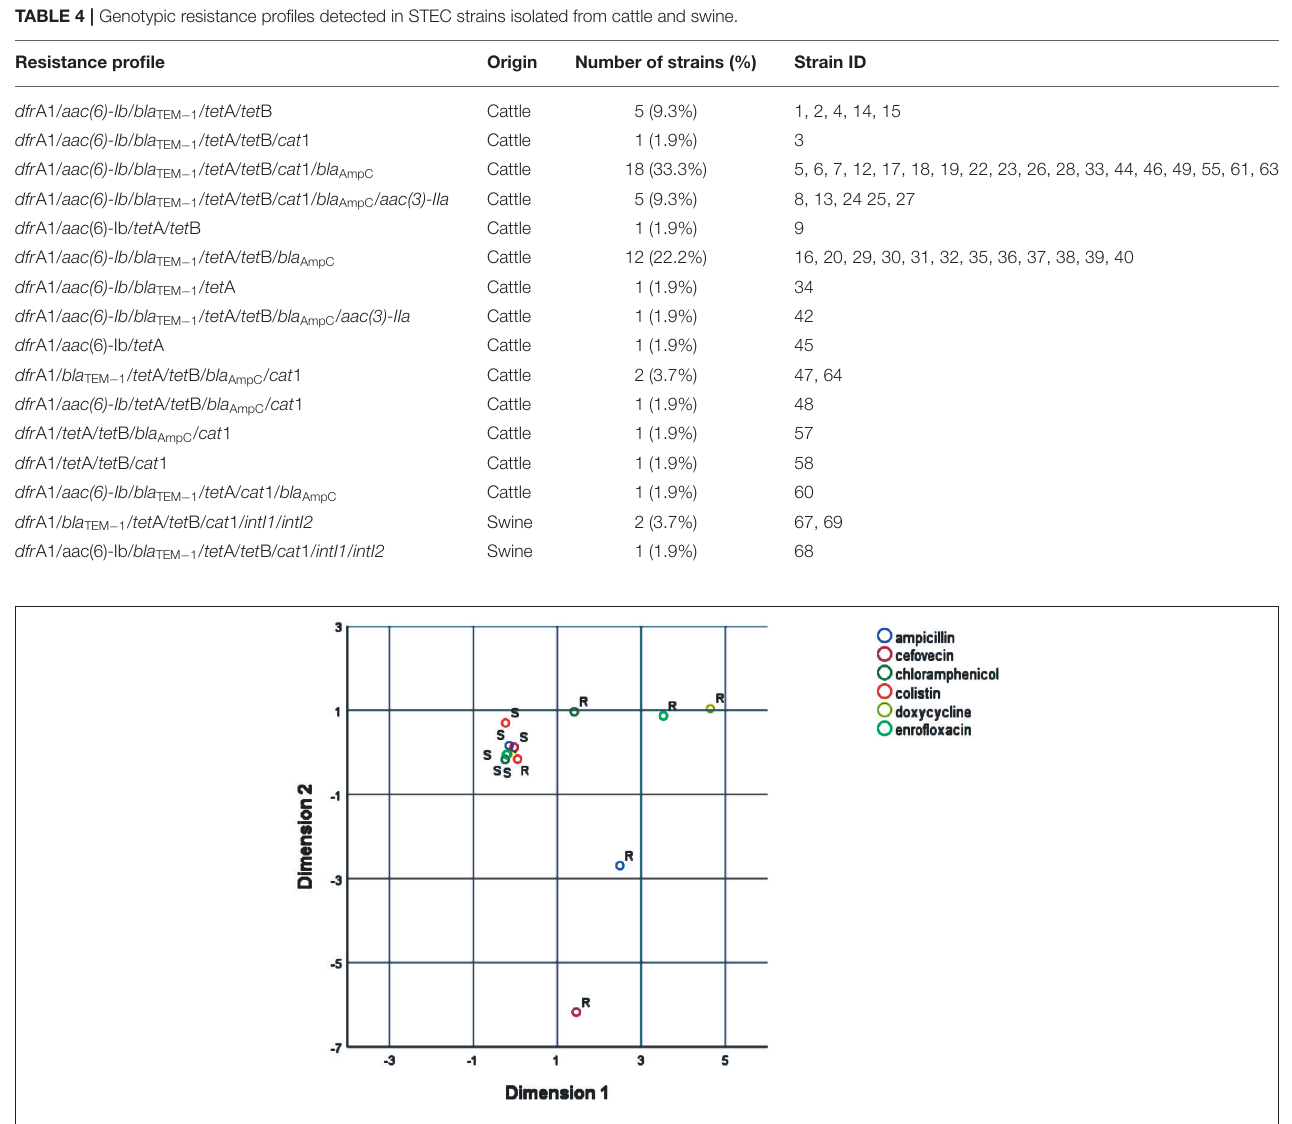
FIGURE 1 | Two-dimension correspondence map for phenotypic AMR characterization (S, sensitive; R, resistant).